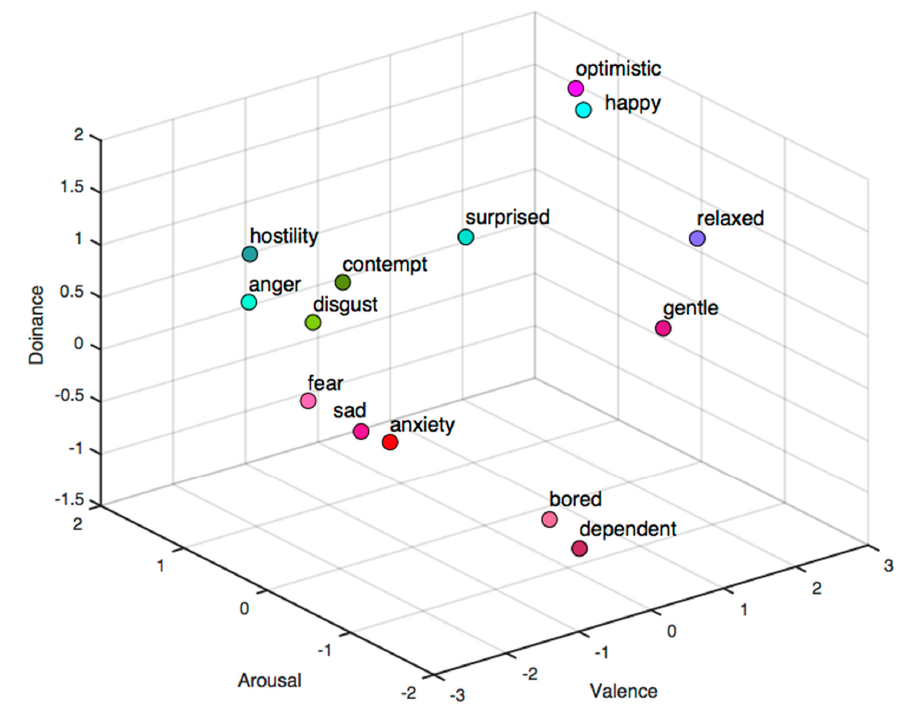
Figure 3. 3D emotion space model.